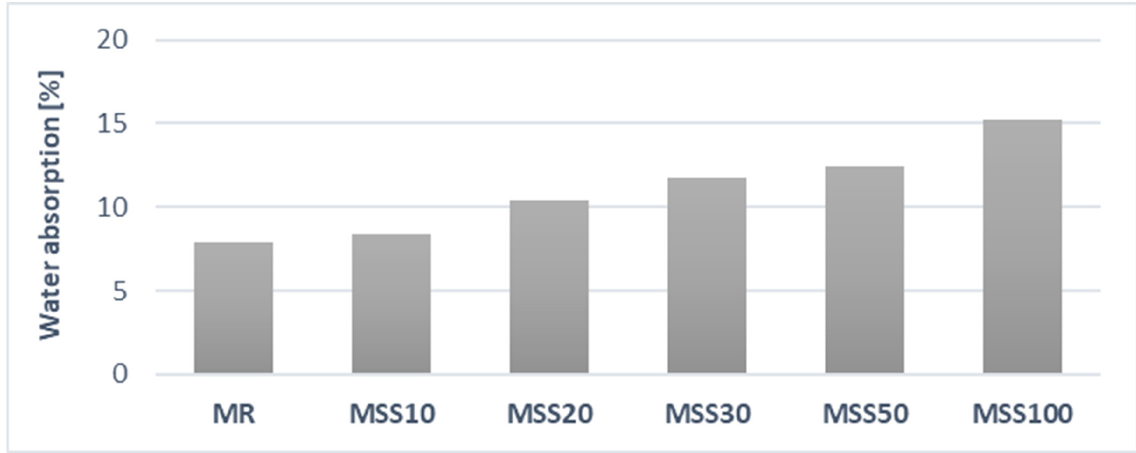
Figure 17. Water absorption of studied mortars.